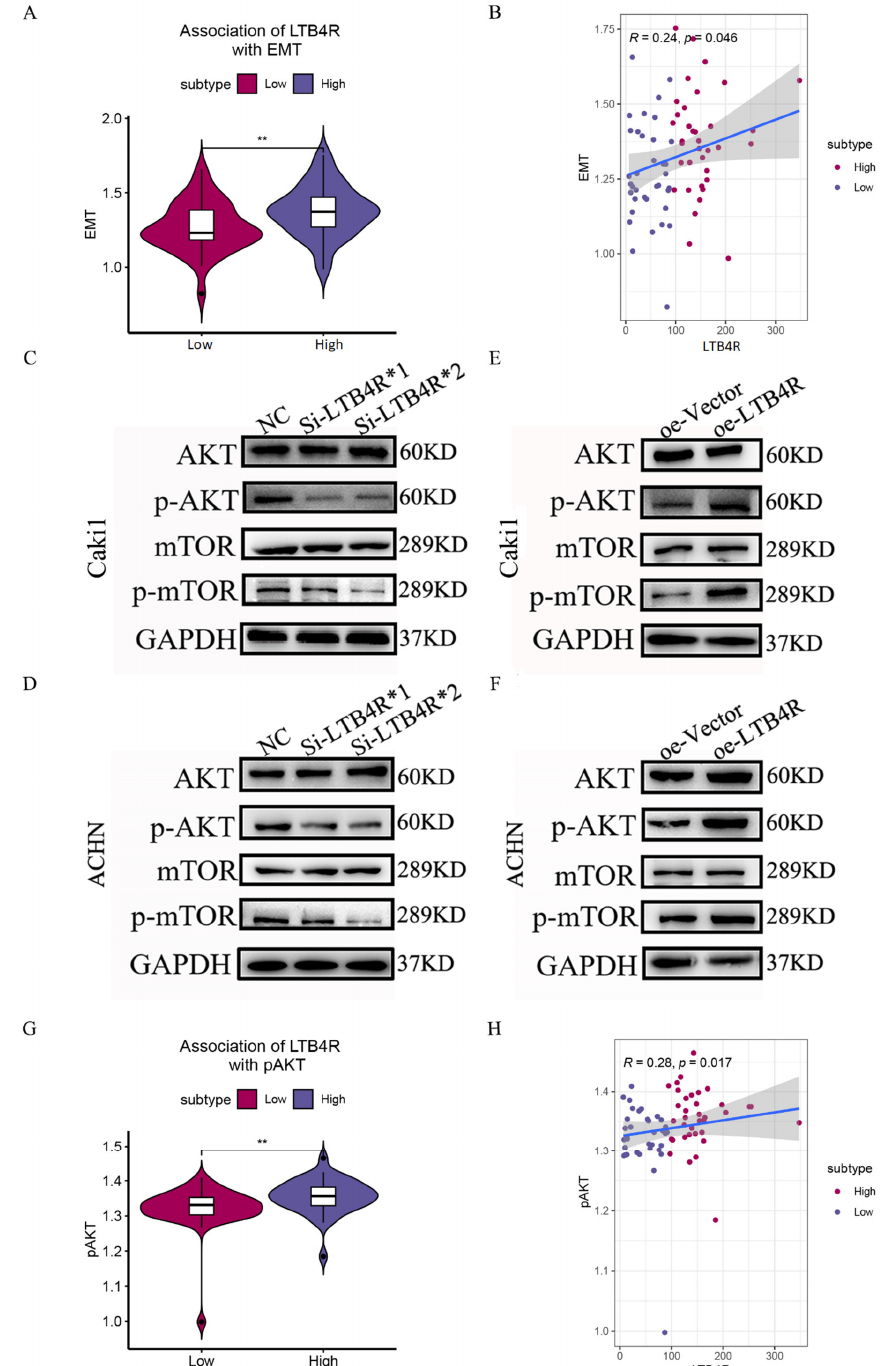
Figure 8. The association of LTB4R with EMT and the effects of LTB4R on the AKT/mTOR pathway. ( A ) The difference of EMT scores defined by using ssGSEA between LTB4R high expressed group and LTB4R low expressed group. Wilcoxon rank-sum test, ** p < 0.01. ( B ) The association of LTB4R expression with EMT score. ( C , D ) Western blot analysis showed that knockdown of LTB4R reduced the expression of p-AKT and p-mTOR in Caki1 and ACHN cells. ( E , F ) Western blot analysis showed that overexpression of LTB4R increased the expression of p-AKT and p-mTOR in Caki1 and ACHN cells. ( G ) The difference of AKT/mTOR signaling pathway scores defined by using ssGSEA between LTB4R high expressed group and LTB4R low expressed group. Wilcoxon rank-sum test, ** p < 0.01. ( H ) The association of LTB4R expression with AKT/mTOR signaling pathway score, (** p <